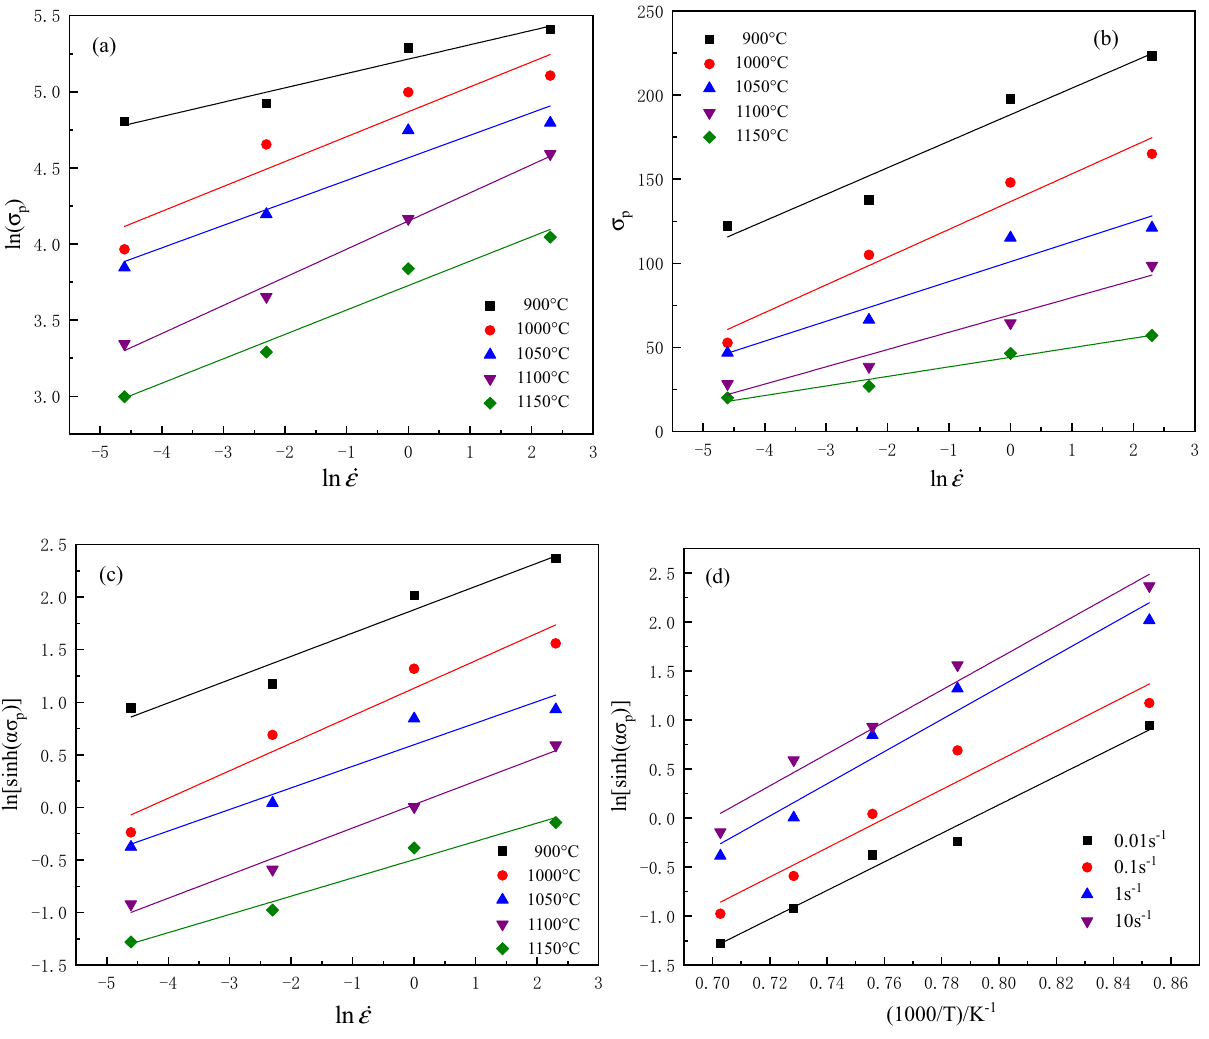
Figure 4: Linear relationship of ( a ) ε ln ̇ - σ p , ( b ) ε ln ̇ - σ p , ( c ) ε ln ̇ - ln [ sinh ( ασ p )] , ( d ) ln [ sinh ( ασ p )]-( 1,000/ T ) . Scattered points are measured data, and lines represent liner fi tted data.